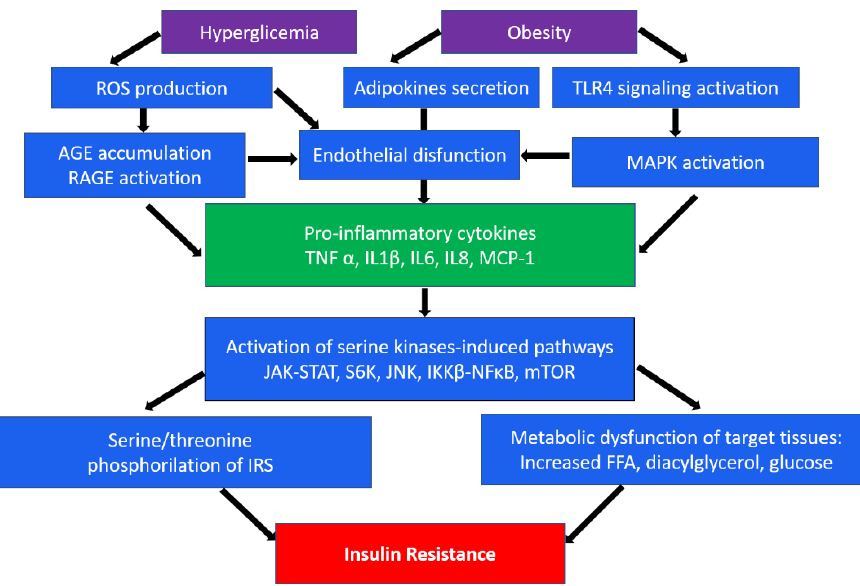
Figure 1. A brief scheme of the main inflammatory mechanisms in the development of insulin resistance. ROS, reactive oxygen species; TLR4, toll-like receptor 4; AGE, advanced glycation end- products; RAGE, AGE receptor; MAPK, mitogen-activated protein (MAP) kinase; TNF α , tumor necrosis factor α ; IL, interleukins; MCP-1, monocyte chemoattractant protein-1; JAK-STAT, Janus kinase signal transducers as well as activators of transcriptional signaling pathway; S6k, ribosomal protein S6 kinase; JNK, c-Jun N-terminal kinase signaling pathway; NF- κ B, nuclear factor- κ B pathway; mTOR, mammalian target of rapamycin; IRS1, insulin receptor substrate 1; FFA, free fatty acids. It is known that adipose tissue consists mainly of adipocytes, as well as